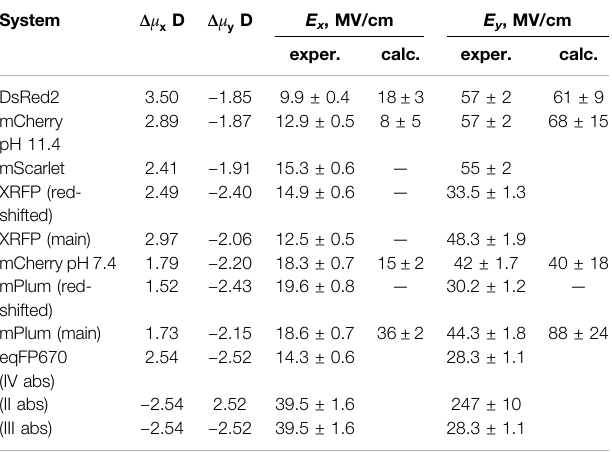
Table3| Componentsof Δ μ vectorandcorrespondingelectric fi eldsforaseriesof